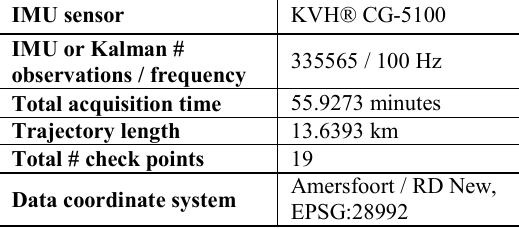
Table 1: Trajectory’s characteristics.